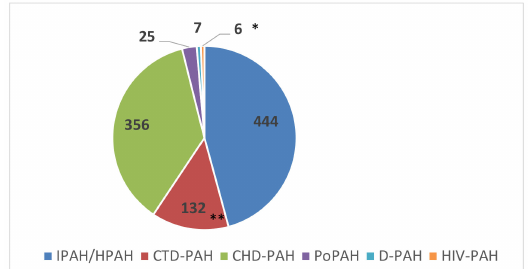
Figure 2. Number of patients with di ff erent types of pulmonary arterial hypertension according to clinical classification. In the group of IPAH / HPAH only 12 patients were diagnosed with HPAH based on genetic testing, however PAH patients were not systematically checked for genetic background. CHD-PAH–pulmonary arterial hypertension (PAH) associated with congenital heart disease, CTD-PAH-PAH associated with connective tissue disease, DPAH—drugs and toxin induced PAH, HIV-PAH—PAH associated with HIV infection, HPAH—heritable PAH, IPAH—idiopathic PAH, PoPAH—PAH associated with portal hypertension. * Among patients with CTD-PAH ( n = 132), the most frequent were diseases of the scleroderma spectrum (SSc-PAH, n = 63) followed by mixed connective tissue disease ( n = 22), rheumatoid arthritis ( n = 15), systemic lupus erythematosus ( n = 13), polimiositis ( n = 5), and other conditions including overlap syndromes, Sjogren (cid:48) s syndrome, undi ff erentiated systemic rheumatic disease, and dermatomyositis ( n = 14). ** In 7 patients, PAH was attributed to the use of drugs and toxins including roxadustat ( n = 1), dasytinib ( n = 3), interferon ( n = 2), and amphetamine ( n =